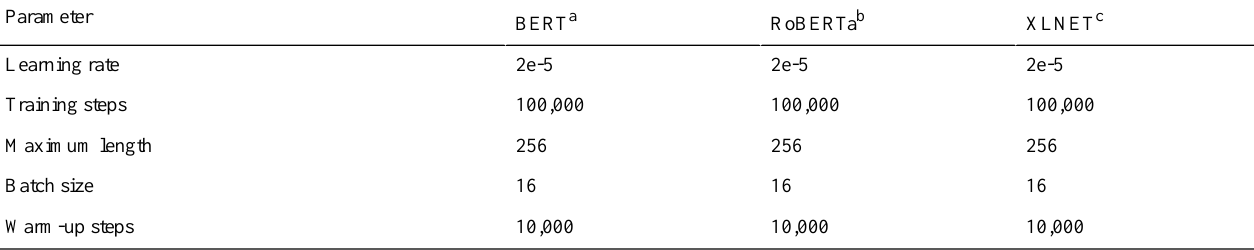
Table 4. Hyperparameters during further in-domain pretraining for the deep-learning